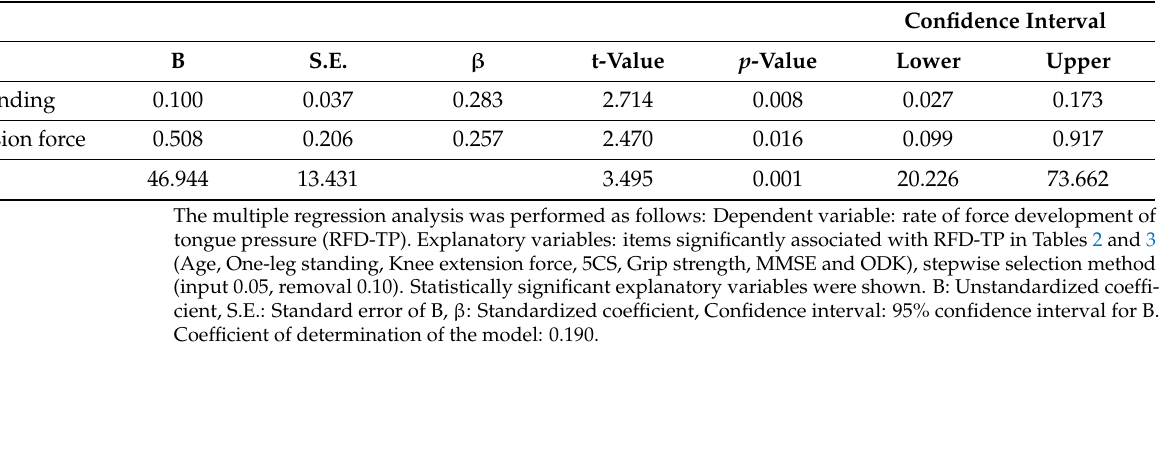
Table 4. Factors associated with